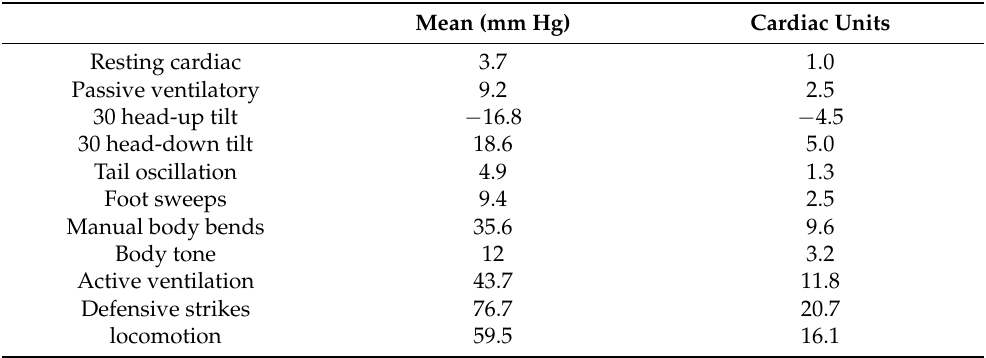
Table 1. Influences on Cerebrospinal fluid pressure in Alligator mississippiensis . The mean pulse amplitudes recorded during each activity, or physiological event, are given both in mm Hg, and in relation to the mean cardiac